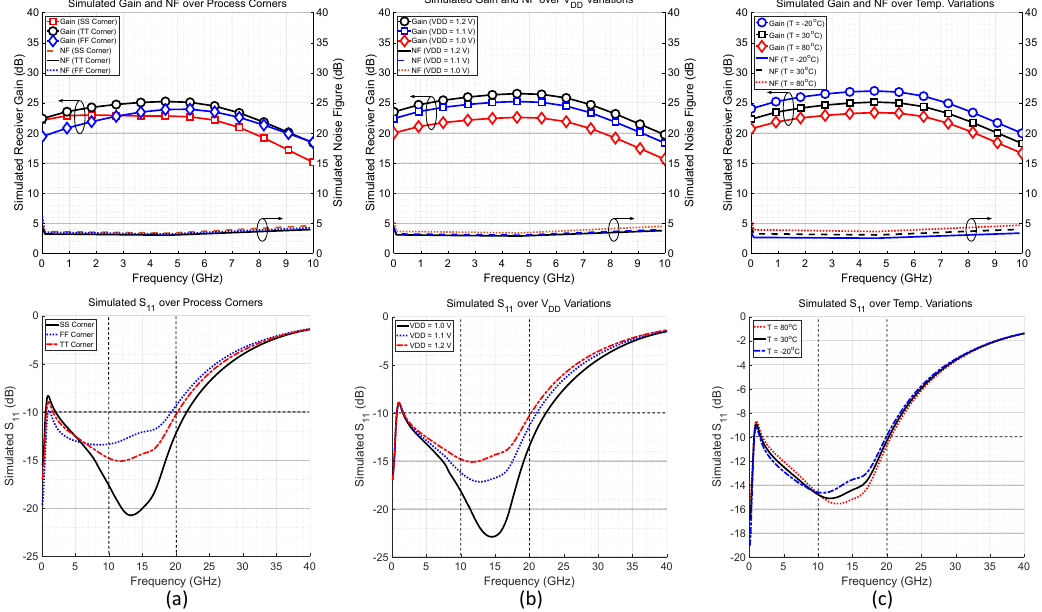
Figure 16. ( a ) Simulated receiver gain, NF, and S 11 over global process corner variation; ( b ) simulated receiver gain, NF, and S 11 over power supply variation; and ( c ) simulated receiver gain, NF, and S 11 over temperature